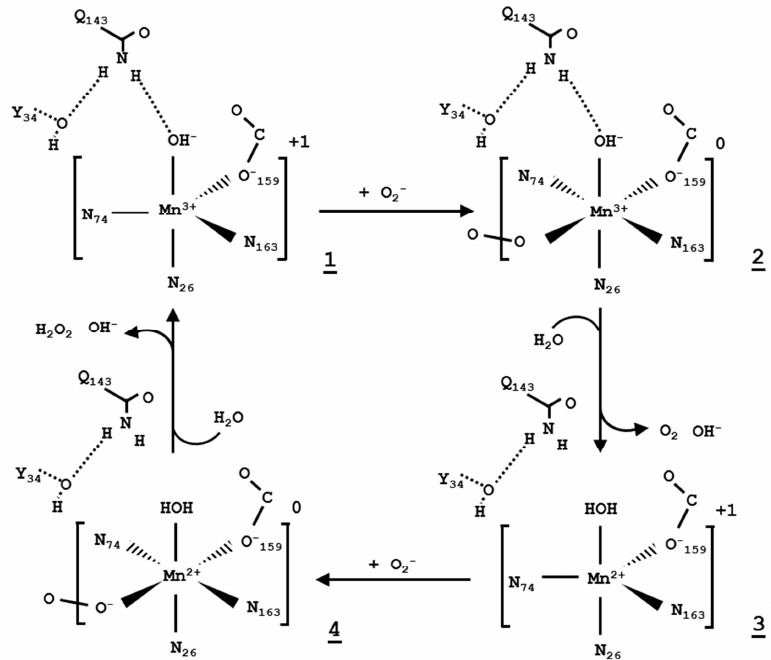
Figure 3. Human MnSOD 5-6-5 mechanism adapted from Lah et al., 1995 [59]. Dotted lines indicated hydrogen bonds.